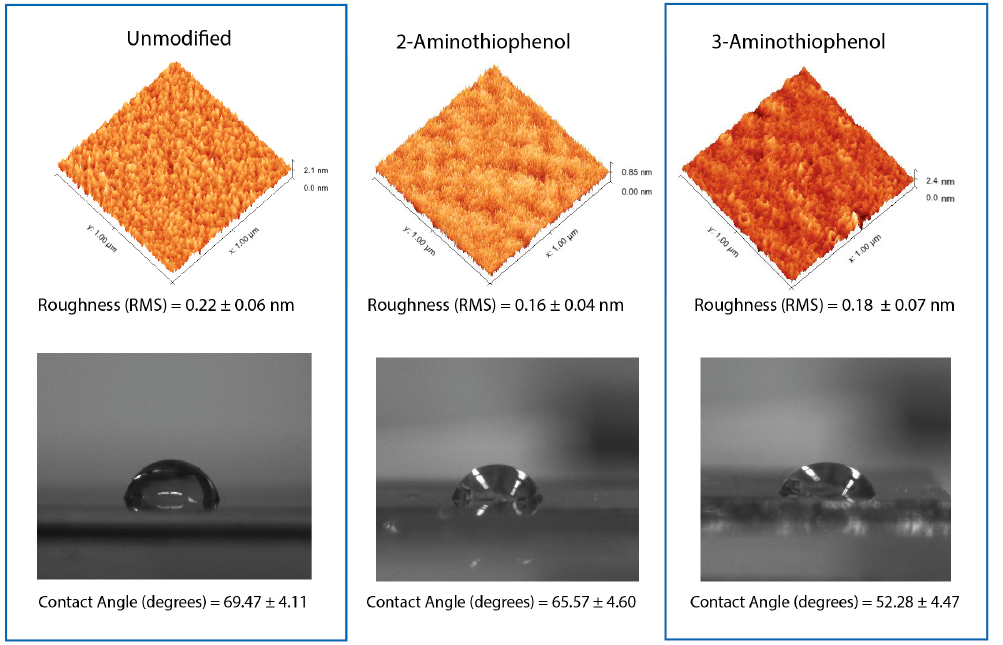
Figure 5. Atomic force microscopy analysis of the respective grafting with an unmodified Si (111) surface serving as a control. Roughness (rms) values and the sessile droplet angles of the surfaces are as shown